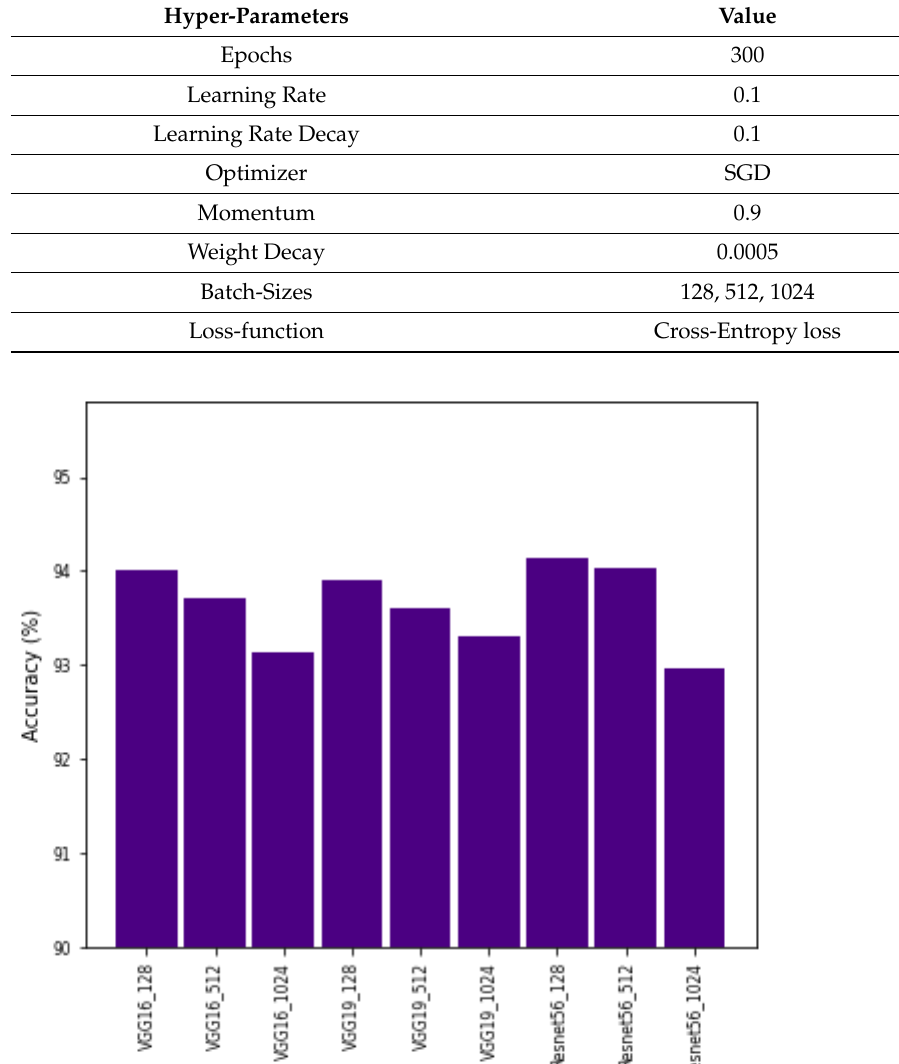
Figure 5. Accuracy of different models.